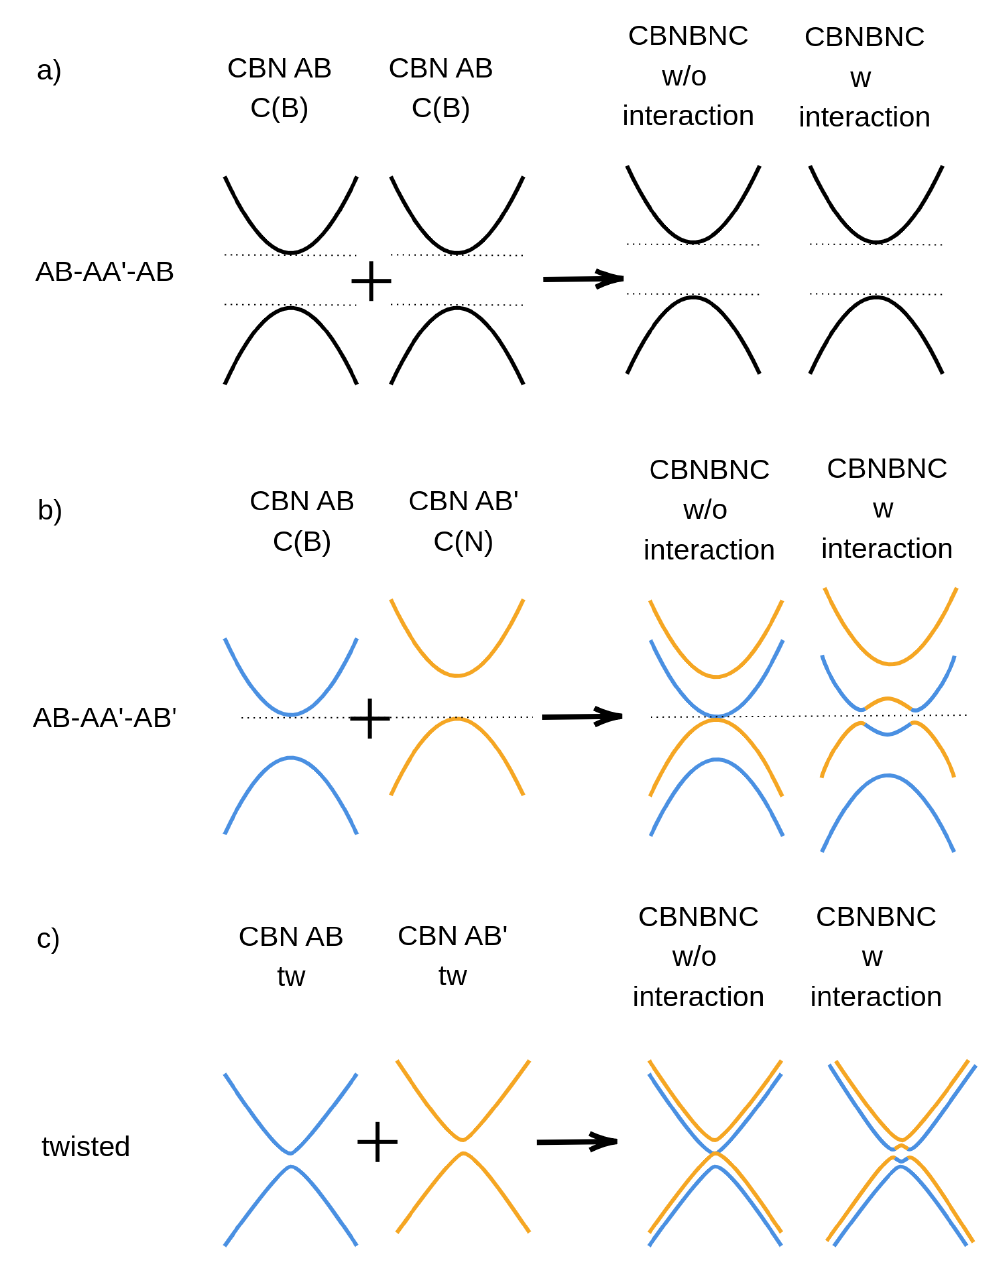
Figure 5. Schematic representation of the contribution of the C-BN bilayers energy states to the band structure of C-BN-BN-C quadrilayers. In the figure, we show both cases with and without the interlayer interaction for the different configurations: AB-AA (cid:48) -AB ( a ), AB-AA (cid:48) -AB (cid:48) ( b ) and twisted ( c ). C(B) script highlights the fact that in the AB stacking a B atom is on top of a C atoms, whereas C(N) indicates that in AB (cid:48) stacking a N atom is on top of a C